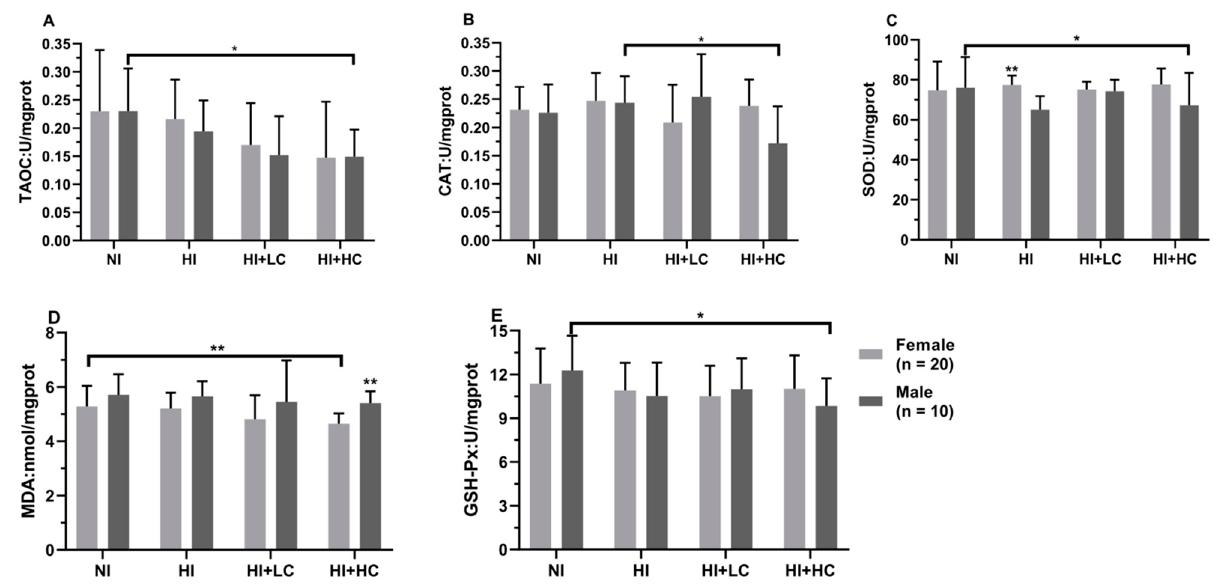
Figure 4. Protection of vitamin C from oxidative damage in the brain for different sexes. ( A ) The activity of TAOC; ( B ) The activity of CAT; ( C ) The activity of SOD; ( D ) The content of MDA; ( E ) The activity of GSH-Px. All data are presented as mean and deviation. ** represents p < 0.01, and * represents p < 0.05.